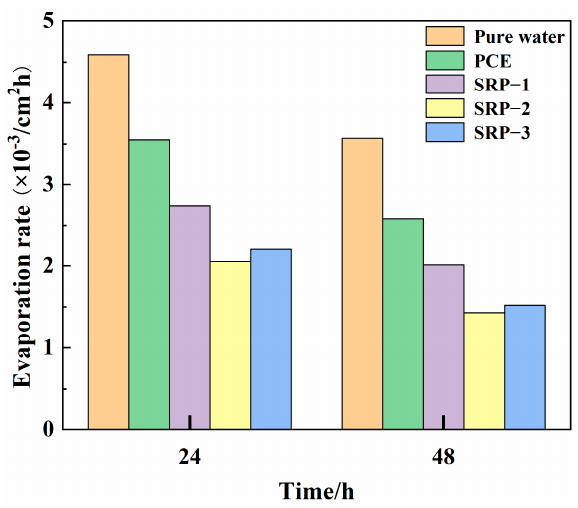
Figure 7. Evaporation rates of PCE and SRP solutions at different times.